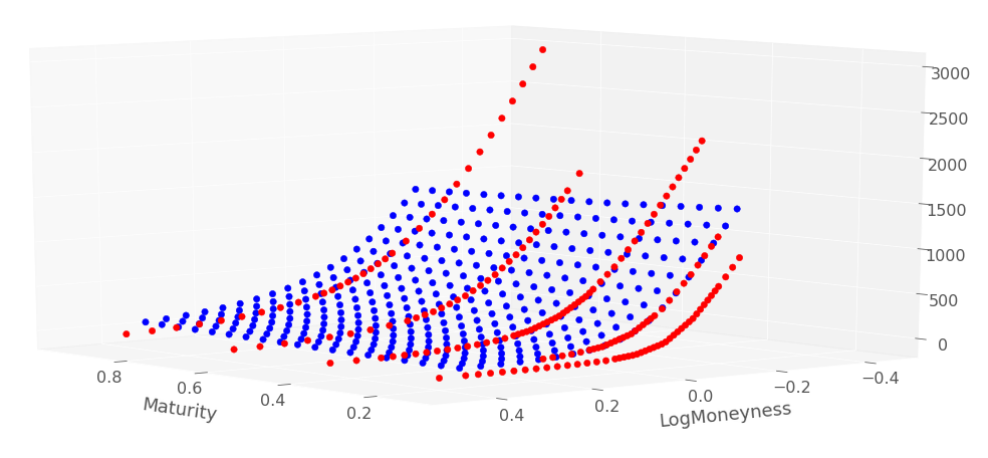
Figure 7. Put prices from training grid (red points) and NN predicted prices at testing grid nodes (blue points), DAX 8 August 2001.